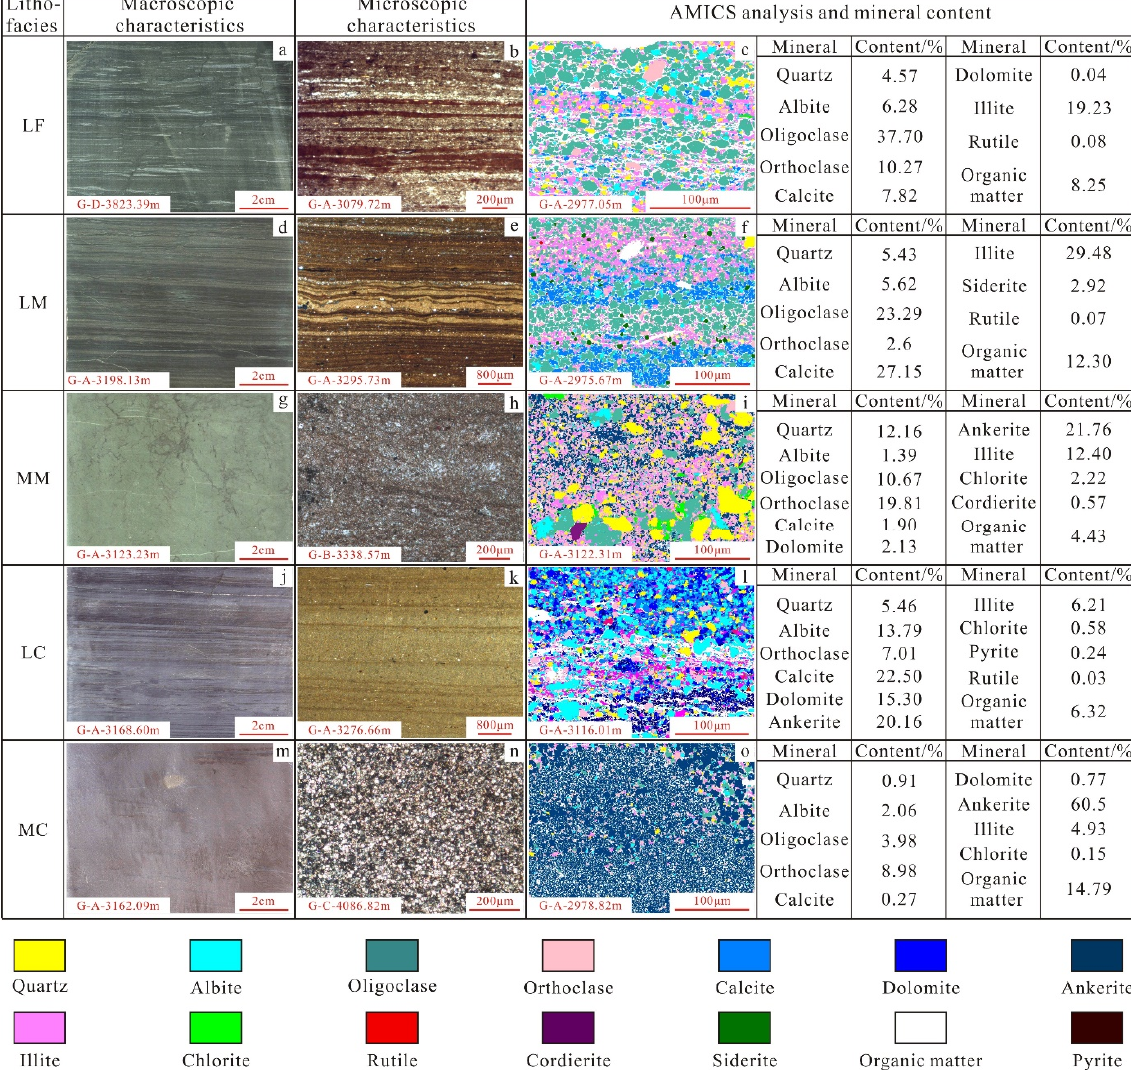
Figure 5. Lithofacies characteristics of the Ek 2 shales in the Cangdong Sag. ( a ) Well G-D, 3823.39